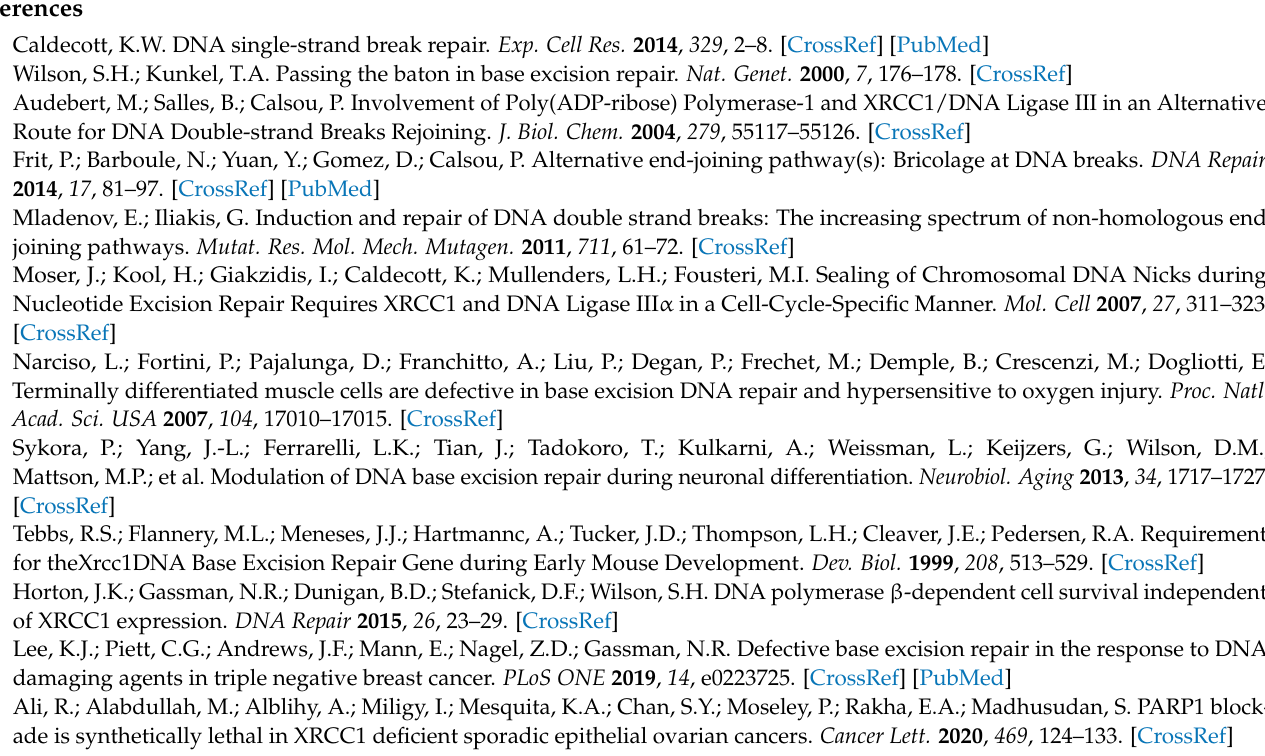
Figure S4: Immunoblotting of cell lines MDA-231, MDA-468 and HEK293T; Figure S5:EGF